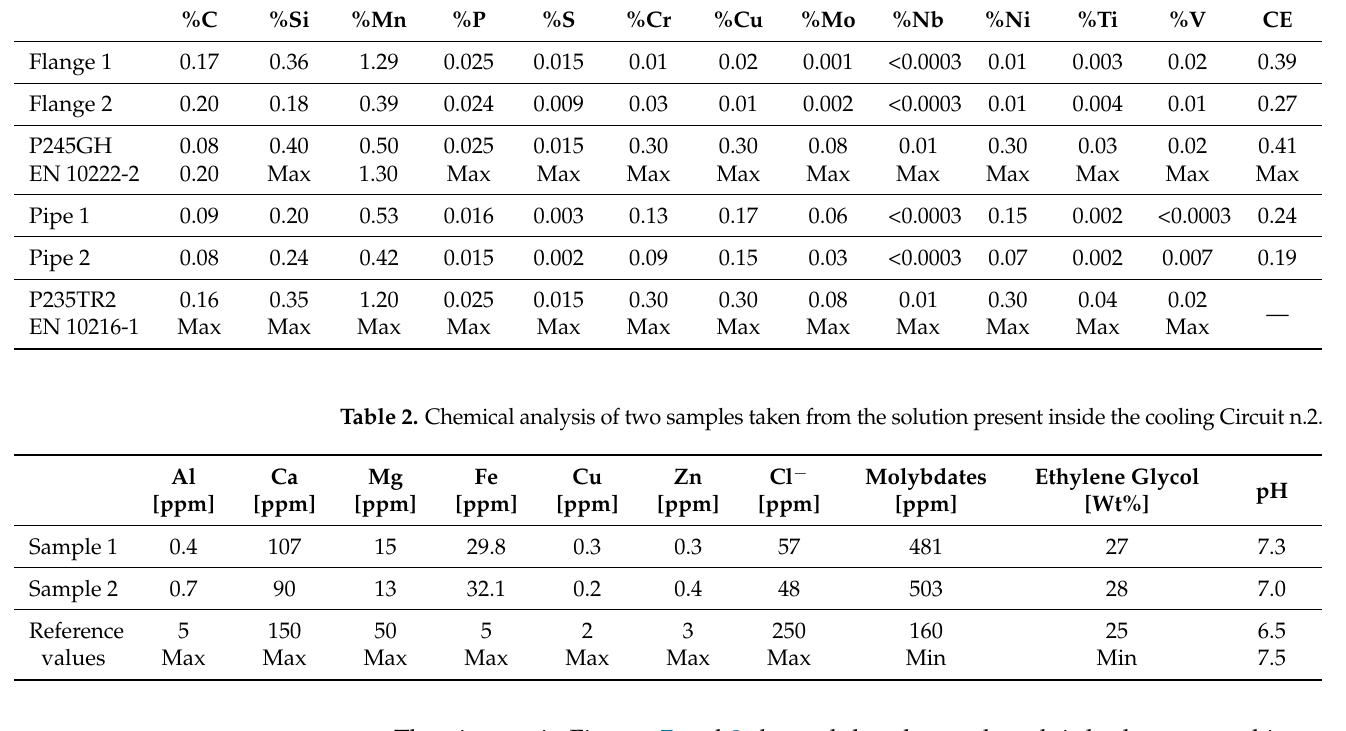
Table 1. Chemical analyses of the investigated steels.